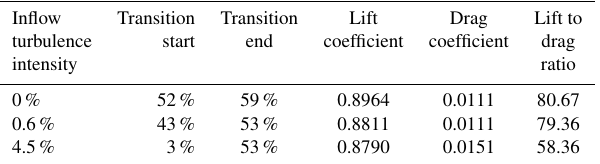
Table 4. Flow configurations and observed transition locations us- ing wall-resolved